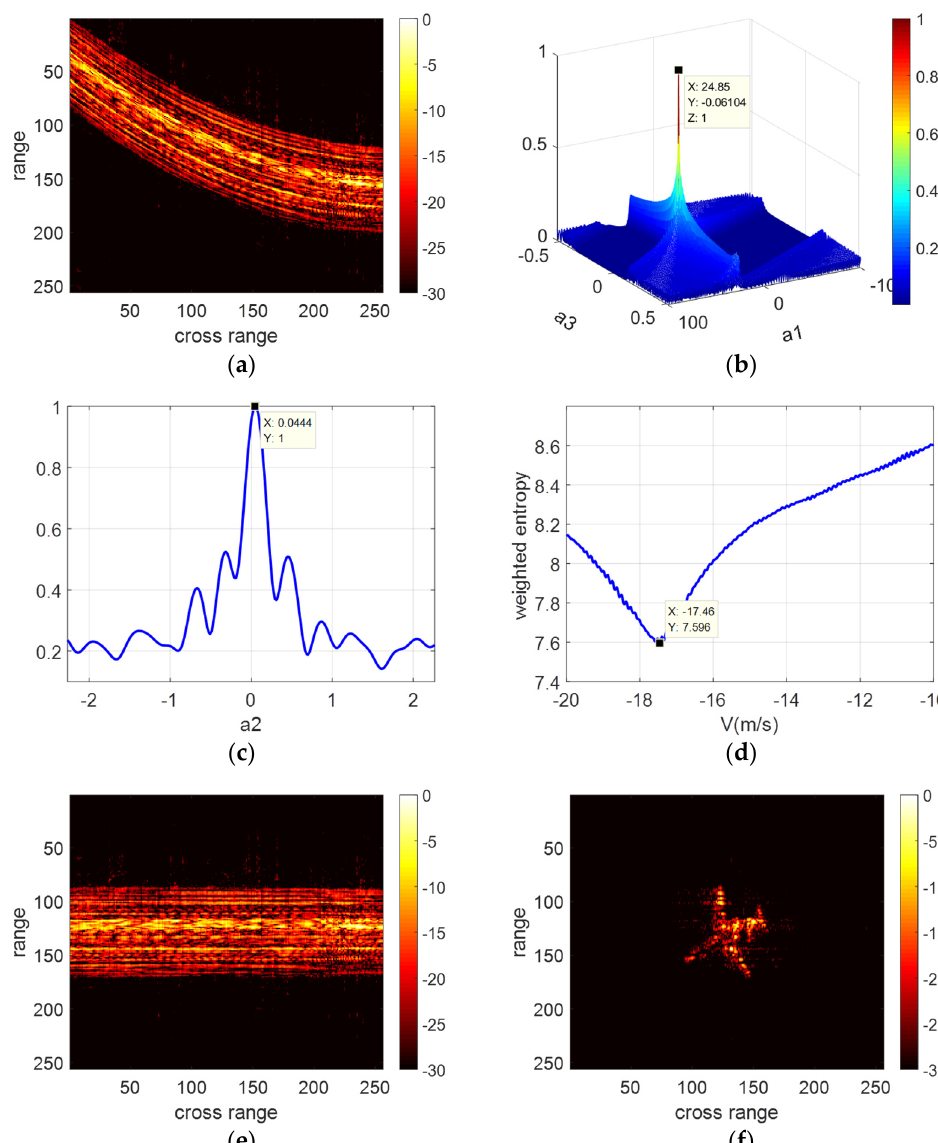
Figure 5. The range profile of the dataset after adding the translational error and the result of each step. ( a ) The range profile of the dataset after adding the translational error. ( b ) The result of HLPT. ( c ) The result of GSCFT. ( d ) The result of MWE. ( e ) The range profile after translational motion compensation. ( f ) The RD imaging result after translational motion compensation.